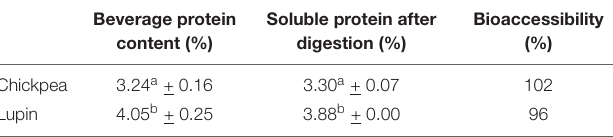
TABLE 3 | Protein content before and after in vitro digestion in chickpea and lupin beverages.